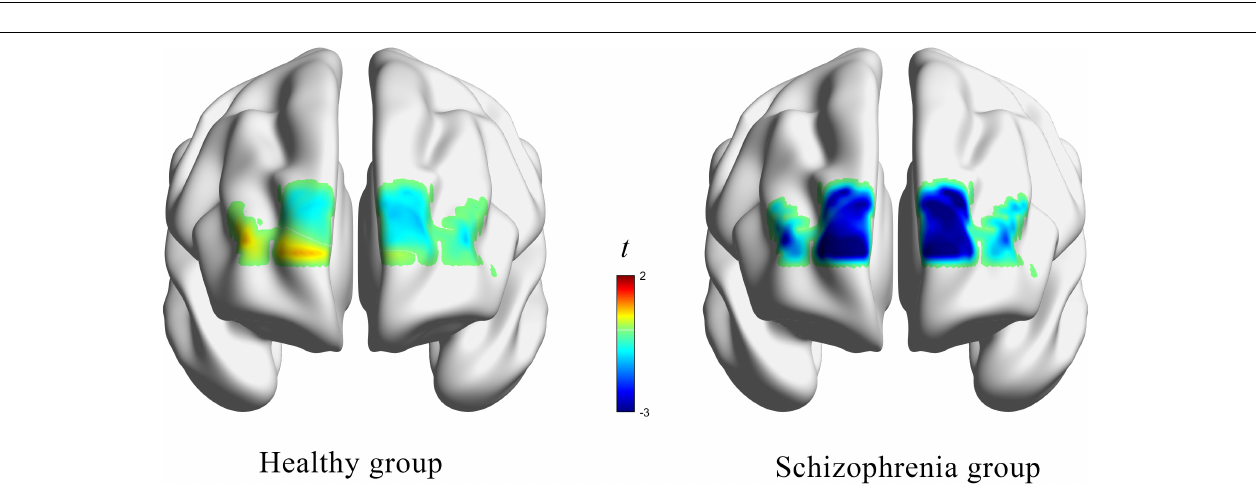
FIGURE 3 | HbO concentration per second changes in participants while watching the emotion-inducing film. The segments with a gray line represent significant differences between the two groups.